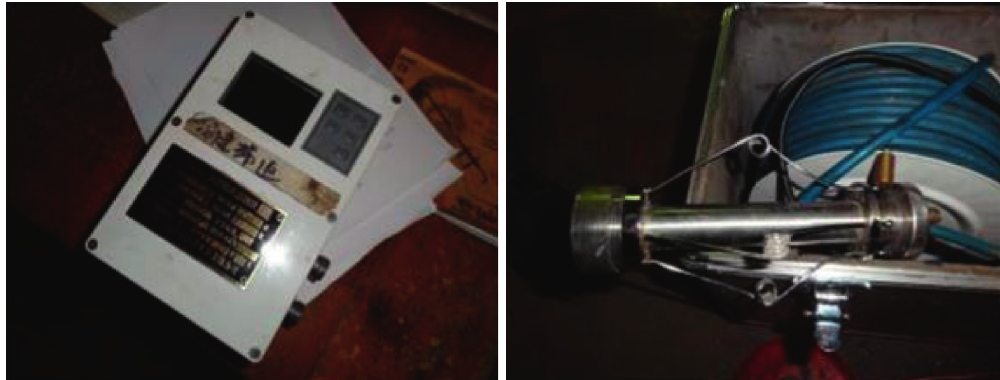
Figure 13: Borehole television